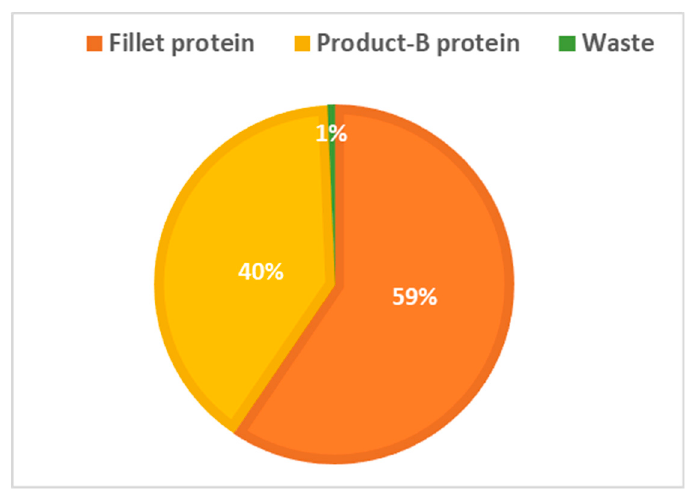
Figure 5. Alternative scenario.